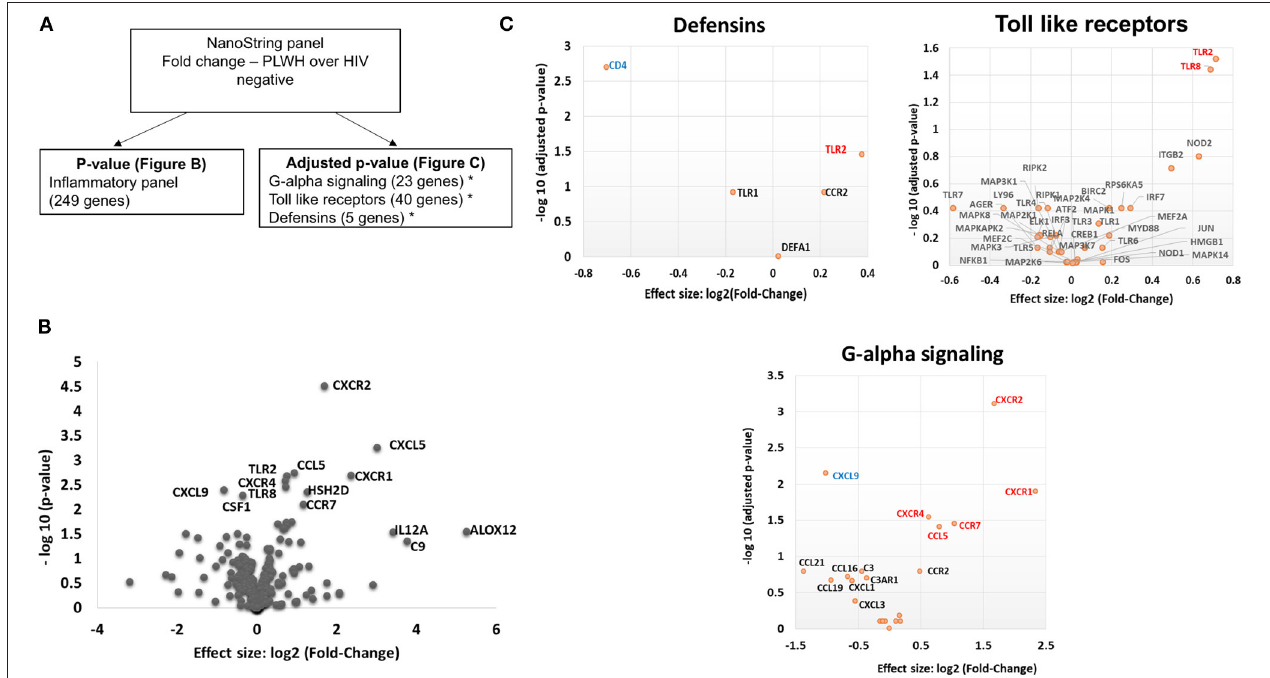
FIGURE 7 | PLWH have a higher CXCR1, CXCR2, CXCR4, CCL5, CXCL5, TLR2, and TLR8 RNA expression within the subcutaneous adipose tissue compared to HIV negative individuals with similar glucose tolerance. RNA was extracted from subcutaneous adipose tissue of PLWH ( n = 6) and HIV negative individuals ( n = 7). (A) Schematic showing data analysis. (B) Volcano plot showing log 2 fold change (PLWH vs. HIV negative) vs. log 10 p -value. Relevant genes out of 249 genes are labeled. (C) Sub-groups of inflammatory gene panels available through Nanostring were compared and adjusted p -values calculated within these groups. Genes in G-alpha signaling, defensins and Toll-like receptors with significant findings are shown. Red denotes genes that are higher in PLWH and blue denotes higher gene expression in HIV